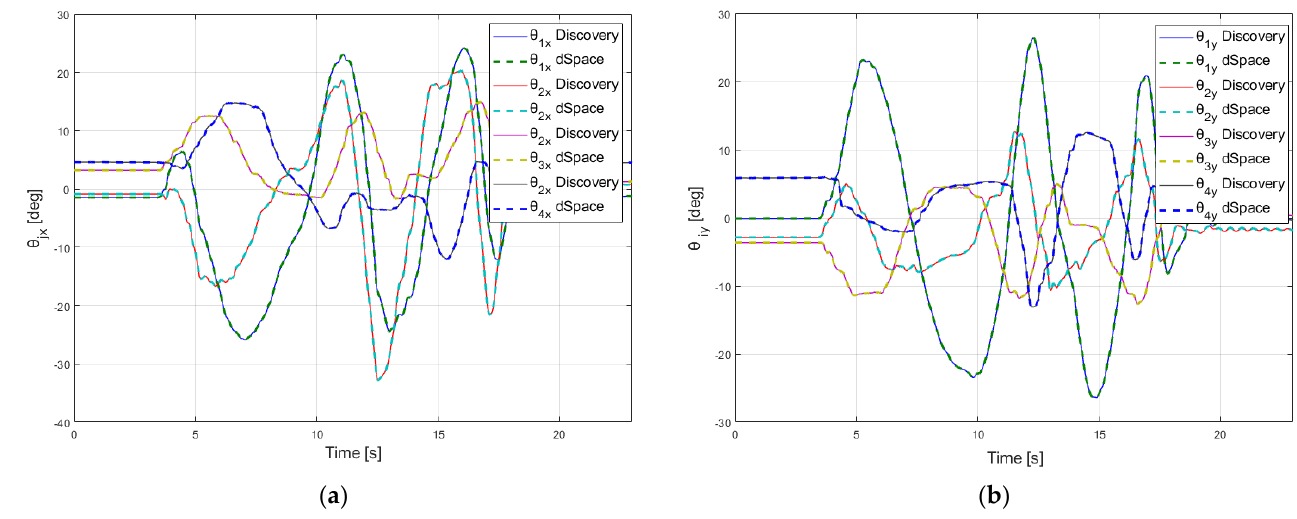
Figure 8. Variation of the relative angles between platforms ( a ) angle θ jx ( b ) angle θ jy . The variation of the position of each platform is presented in Figure 9 (parameter P jx { j = 1...4} in Figure 9a, parameter P jy { j = 1...4} in Figure 9c and parameter P jz { j = 1...4} in Figure 9e. The absolute error for each platform for the three parameters is presented in Figure 9b,d,f. The obtained maximum absolute error for P jx parameter is 0.083 mm, for P jy is 0.049 mm and for P jz parameter is 0.129 mm. As can be seen, the absolute errors are higher in the upper platforms, which is caused by a much bigger amplitude of position variation for these modules in comparison with the modules at the robot base.